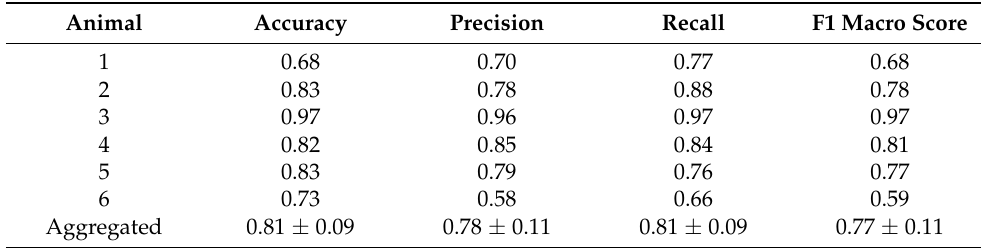
Table 3. Performance of multi-class classifier based on leave-one-subject-out analysis (1st-stage random forest and 2nd-stage logistic regression). Aggregated performance is shown in terms of mean and standard deviation. NV: normovolemia. HV: hypovolemia. AH: absolute hypovolemia. RH: relative hypovolemia.